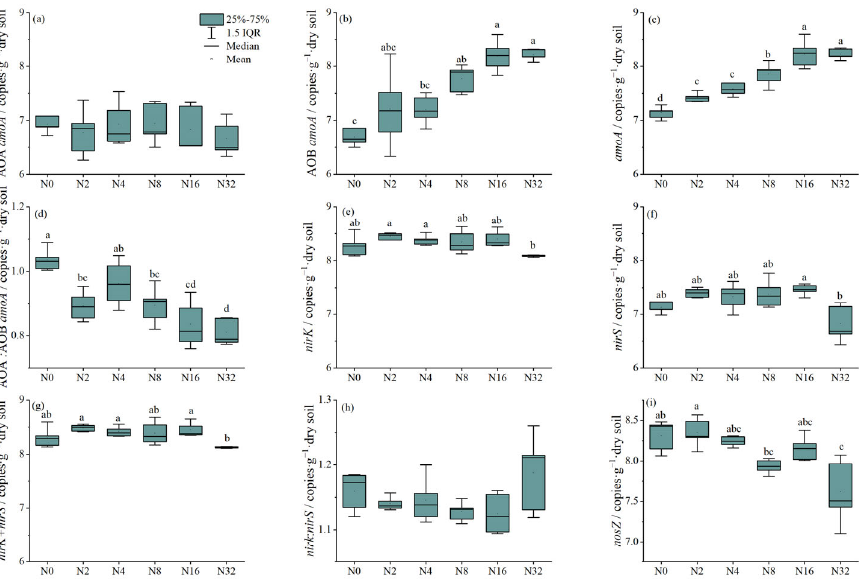
Figure 2. Boxplot of the abundances of the functional genes of the soil nitrifiers and denitrifiers under different N application rates. ( a ) gene abundance of AOA amoA , ( b ) gene abundance of AOB amoA , ( c ) gene abundance of amoA , ( d ) the ratio of AOA:AOB amoA , ( e ) gene abundance of nirK , ( f ) gene abundance of nirS , ( g ) gene abundance of ( nirK + nirS ), ( h ) the nirK : nirS ratio, and ( i ) nosZ. In all, 25–75% represents the interquartile range (IQR). Different lowercase letters indicate significant differences among all the N application treatments ( p < 0.05). N0 is the control (0 g N · m − 2 · yr − 1 application), N2 is the 2 g N · m − 2 · yr − 1 application, N4 is the 4 g N · m − 2 · yr −